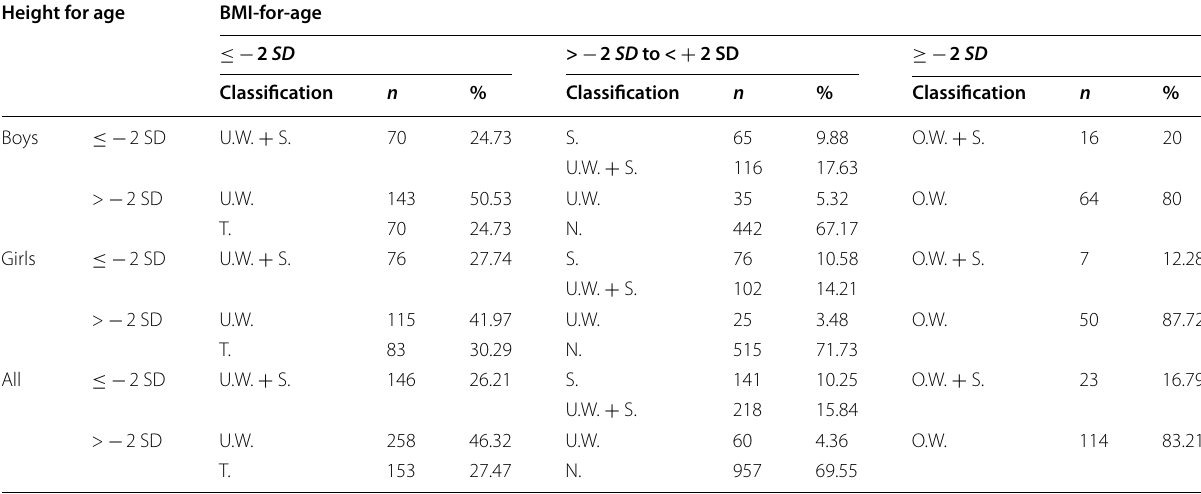
U.W underweight, S stunting, T thin, N normal, O. W overweight